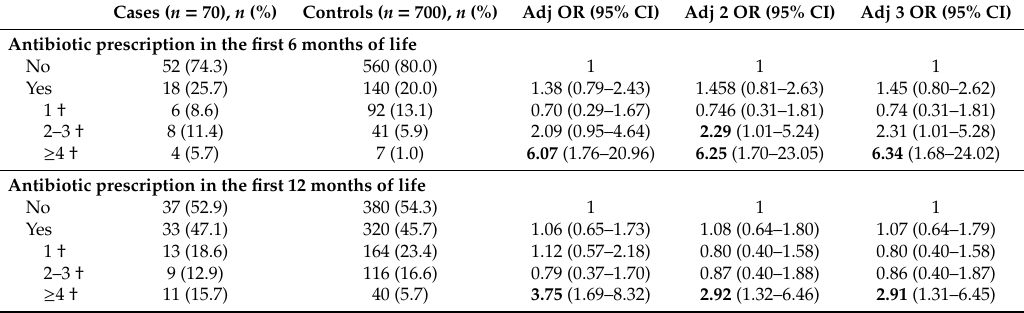
Table 3. Risks of antibiotic exposure in the first 6 and 12 months of life, in the development of childhood onset